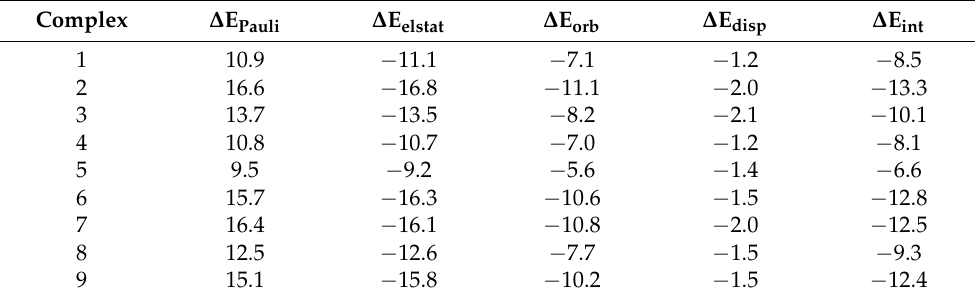
Table 6. The energy terms for complexes analyzed here that result from the decomposition of the energy of interaction (in kcal/mol); ∆ E Pauli —the Pauli repulsion, ∆ E elstat —the electrostatic term, ∆ E ∆ E orb —the orbital interaction energy, disp —the dispersion interaction energy term, total interaction energy (Equation (5)). The numeration of complexes follows Figure